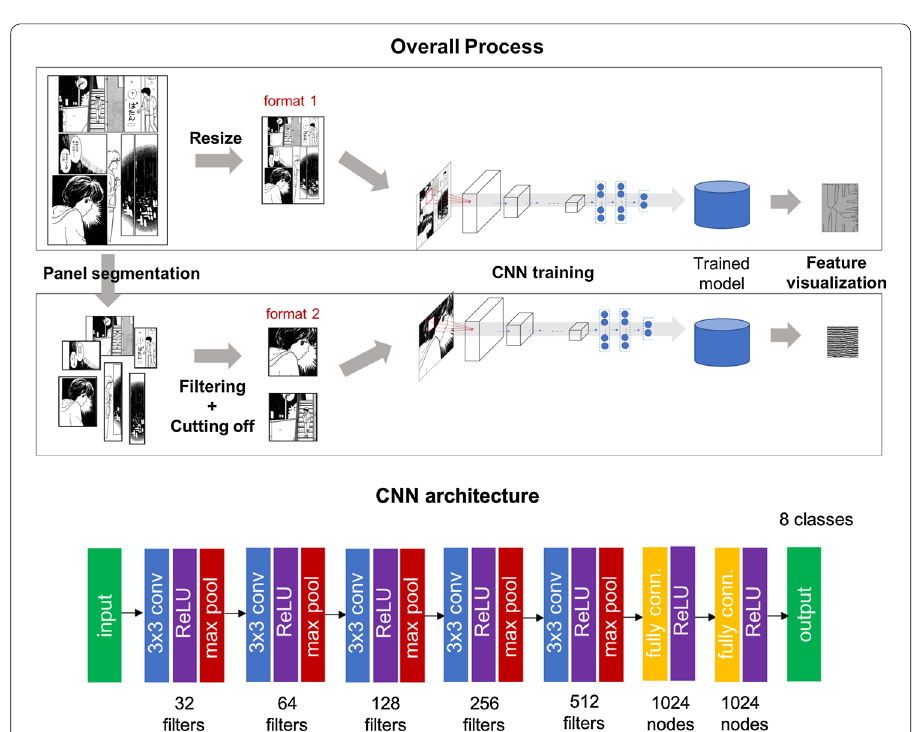
Fig. 3 The overall process of our approach and the CNN architecture for the classification of comic artist